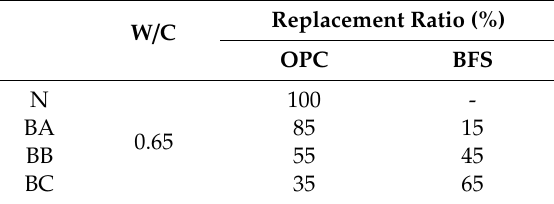
Table 2. Mixture design of paste